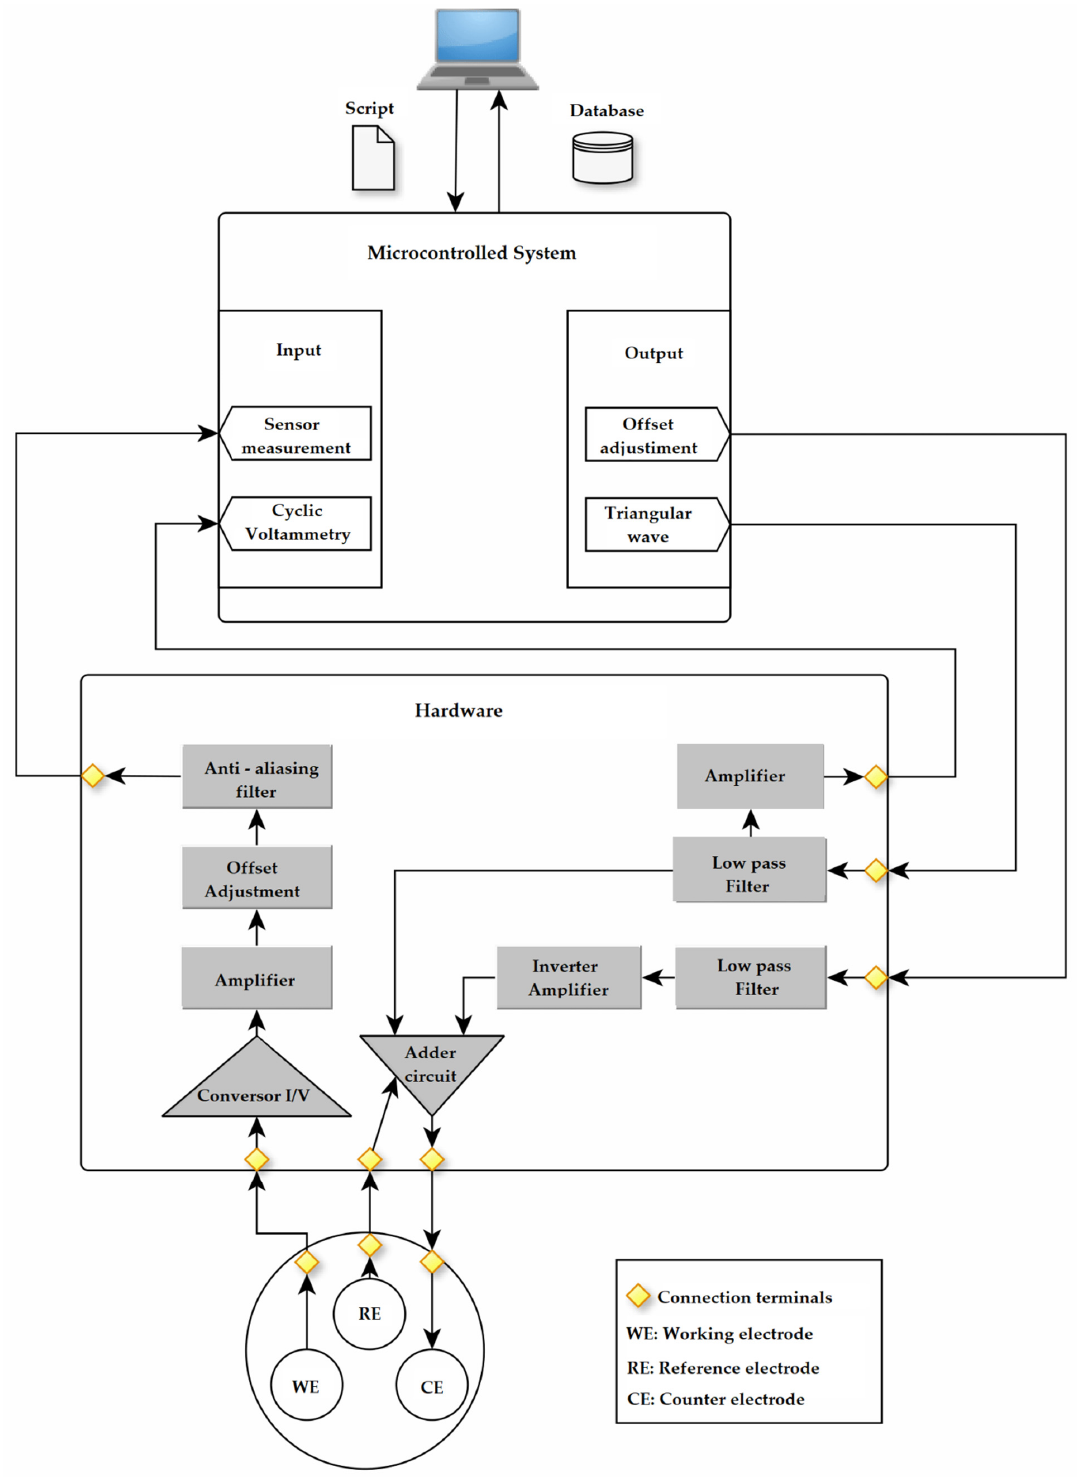
Figure 2. Block diagram of the proposed portable potentiostat developed to electrochemically